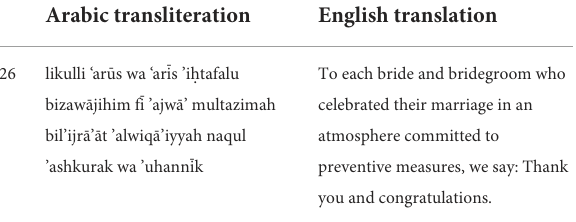
TABLE 9 Examples of the use of the social proof–commitment